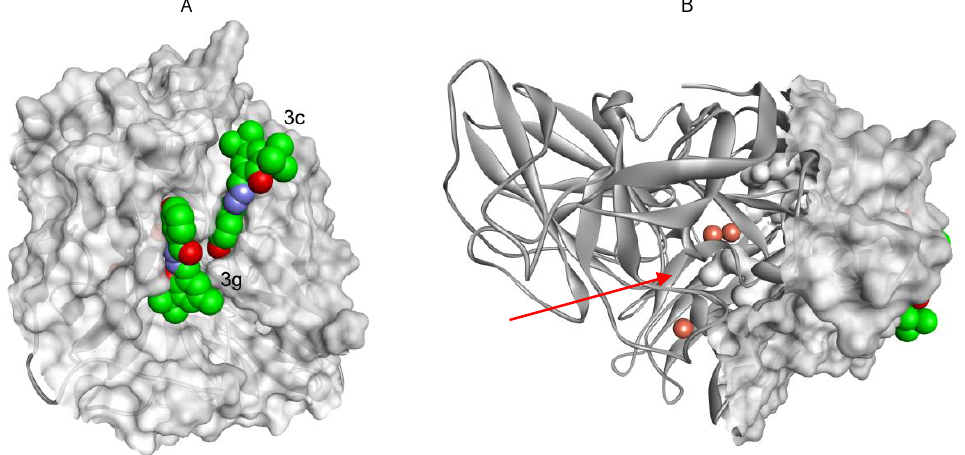
Figure 6. Interaction of hydrazide-hydrazones 3c and 3g on the surface of laccase (PDB: 1GYC): ( A ). The red arrow indicates the oxygen tunnel ( B ); the copper ions (type 2 and 3) are shown as orange spheres.